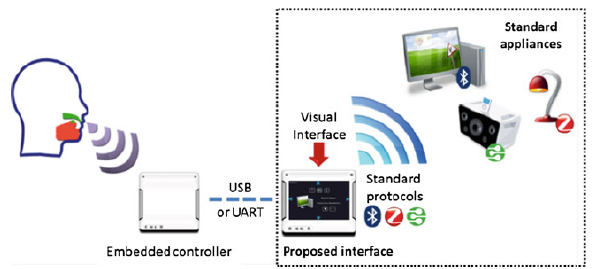
Figura 7. Device control architecture. Source: Paul et al.